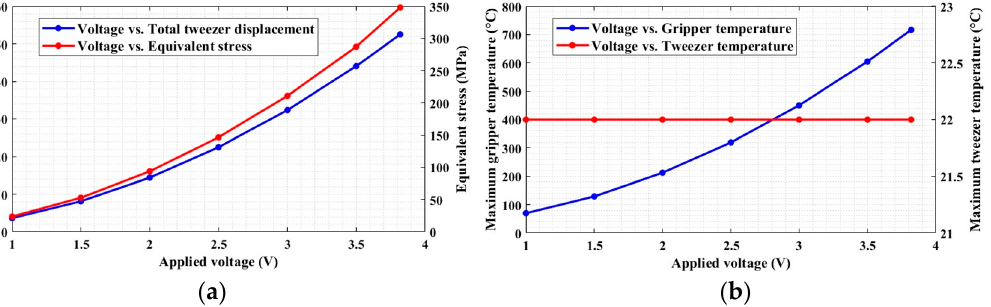
Figure 8. ( a ) Tweezer displacement and equivalent stress as functions of the applied voltage; ( b ) microgripper and tweezer temperature as functions of the applied voltage.